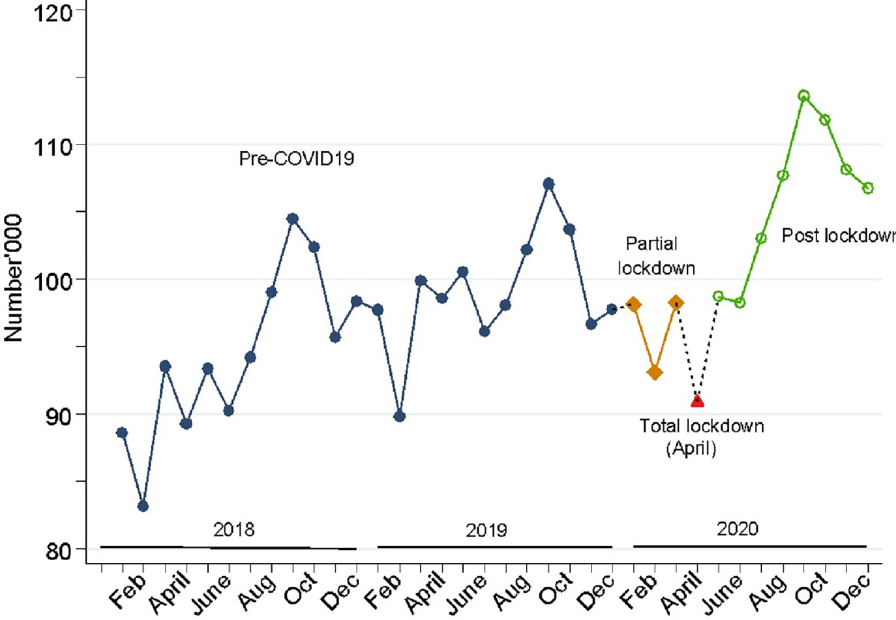
Fig 3. Trends in monthly total number of women delivering in health facilities in Uganda, from 2018 to